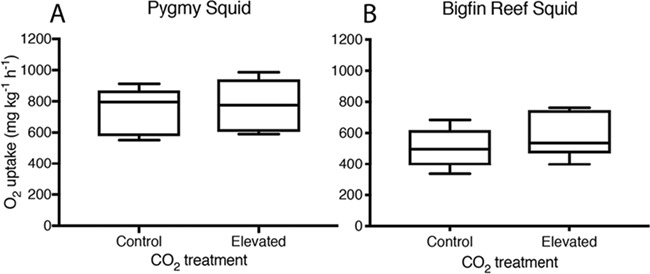
Absolute aerobic scope of pygmy squid (A) and bigfin reef squid (B) from current day control and elevated CO2 treatments; boxplots show the median and interquartile range and the minimum and maximum range of the data.